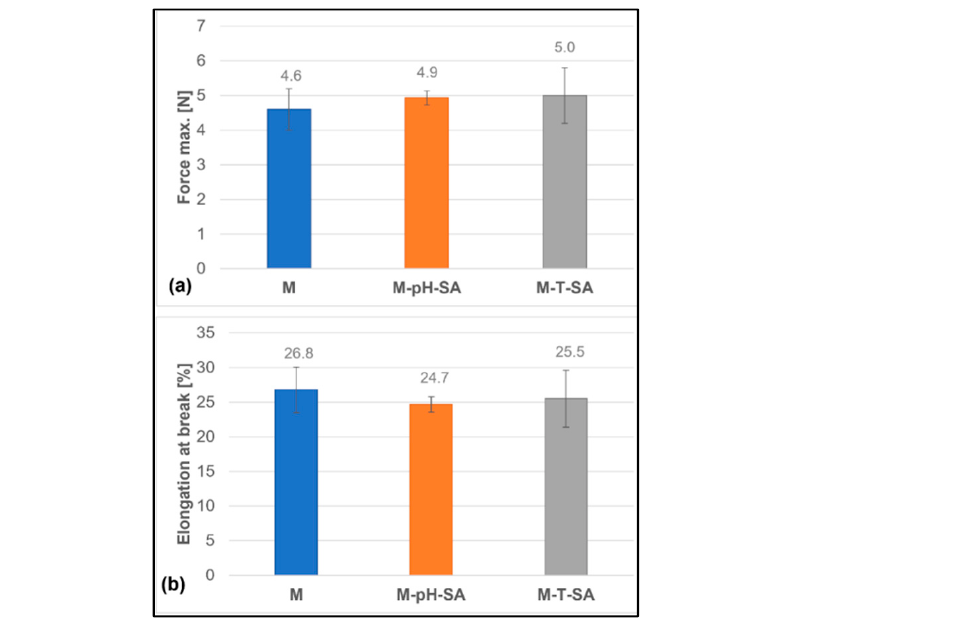
Figure 12. Comparison between the release profile of salicylic acid from thermosensitive nanocarrier (orange line, T-SA) and bio-hybrid hydrogel matrix (blue line, M-T-SA), at pH = 7.4 and T = 37 °C. There are not many reports on the release of salicylic acid from a polymeric thermo- sensitive nanocarrier (poly(N-isopropylacrylamide)). Ji et al. [70] investigated the kinetics of salicylic acid release from chitosan-based polymer carriers. The release profiles ap- peared to have three phases. The first phase was a rapid release or burst release in the prior period, with 45% of the salicylic acid being released in this phase (within the first 4 h). The second phase was a relatively slow release ranging from 4 to 12 h and resulted in the release of 87% of the drug. The third phase was a slower releasing process. Notably, the experiment was conducted by static method and the release time was 70 h. In the case of our studies, the release profile of salicylic acid from a thermosensitive nanocarrier (poly(N-isopropylacrylamide)) (Figure 12) also consists of three phases. In the first stage, we observed the burst release effect (a significant proportion of the encapsu- lated drugs is rapidly released within a short period following application) without the